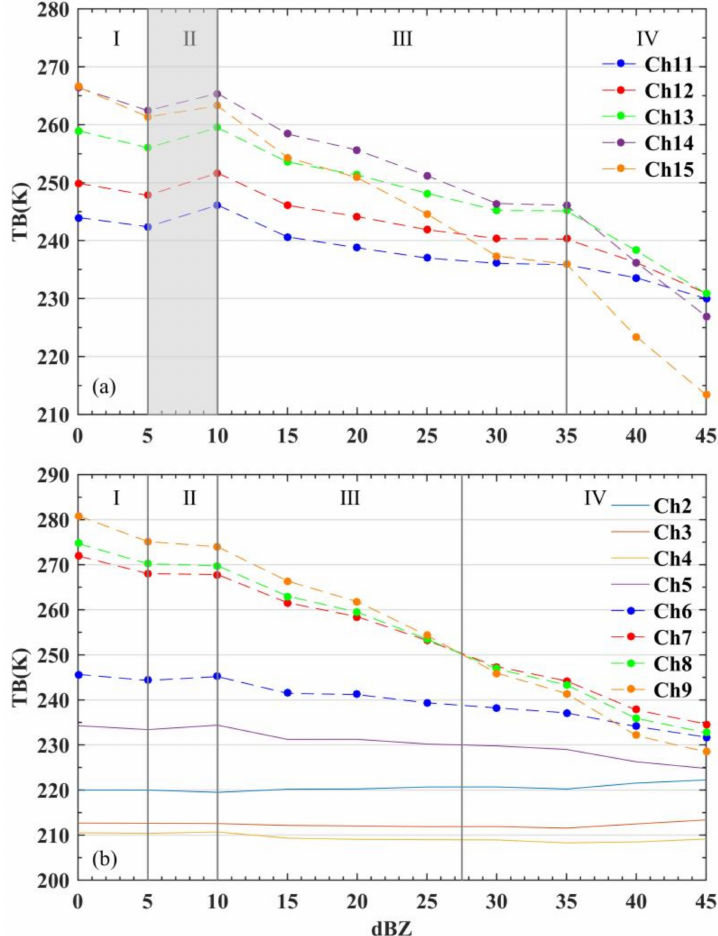
Figure 4. MWHS-2-observed brightness temperature versus radar reflectivity for humidity-sounding channels 11–15 ( a ), and temperature-sounding channels 2–9 ( b ), with data sampled from July to September in 2016. The shaded region in ( a ) indicates that the emission e ff ect of cloud and precipitation results in increasing brightness temperatures. The red line in ( b ) denotes the reversing relationship of brightness temperatures for channels